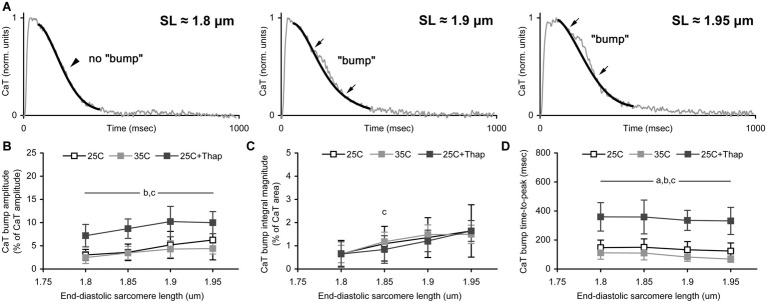
The sarcomere length dependence of Ca-transient (CaT) bump. (A) The representative record of CaT traces demonstrating the effect of sarcomere length on the bump extent. Thin gray line shows original CaT trace, thick black line follows the monotonic decline, the bump is the difference between these two lines. Arrows indicate the points of beginning and ending of the bump. Corresponding sarcomere lengths are shown. (B–D) The CaT bump characteristics obtained in auxotonically contracting isolated rat ventricular cells at room temperature in normal saline (“25C,” N = 4 animals, n = 21 cells); at near-physiological temperature in normal saline (“35C,” N = 3 animals, n = 18 cells); and at room temperature with depleted SERCA2a (“25C + Thap,” N = 3 animals, n = 18 cells). (B) The bump amplitude, as a % of CaT amplitude. (C) The bump integral magnitude (the bump area), as a % of area under complete CaT minus this bump area. (D) The bump time-to-peak, in msec. Data shown as mean ± S.D. Horizontal lines with the significance symbol(s) show the range where this significance is found. a – significant difference between “25C” and “35C”; b – significant difference between “25C” and “25C + Thap”; c – significant difference between “35C” and “25C + Thap” (Mann-Whitney U-test, p < 0.05).